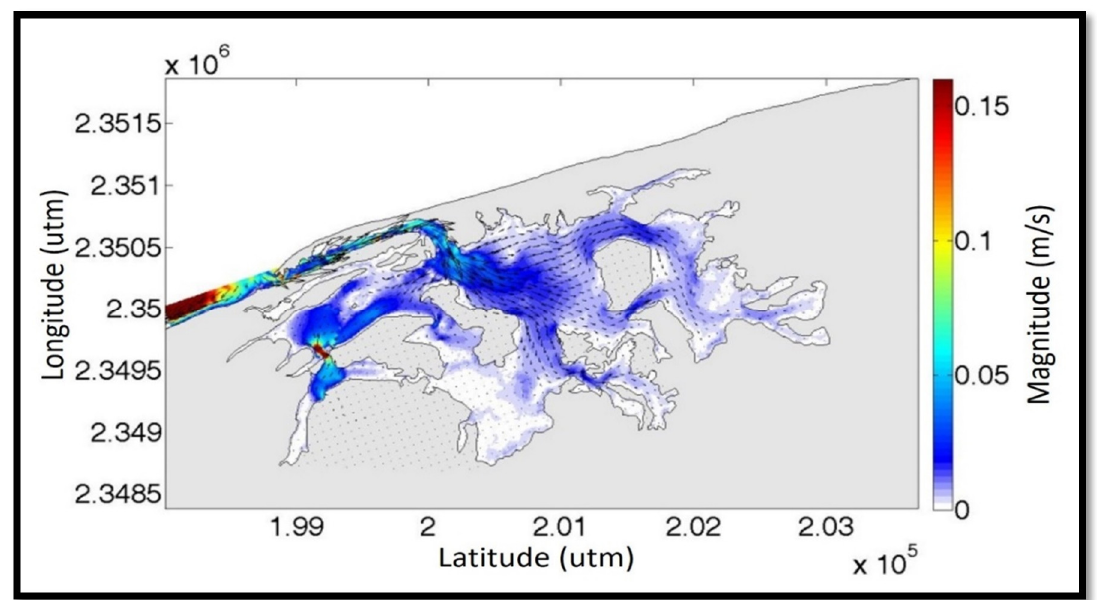
Figure A3. Example of the residual circulation pattern (m/s) during a spring tide with sea breeze forcing [33] .